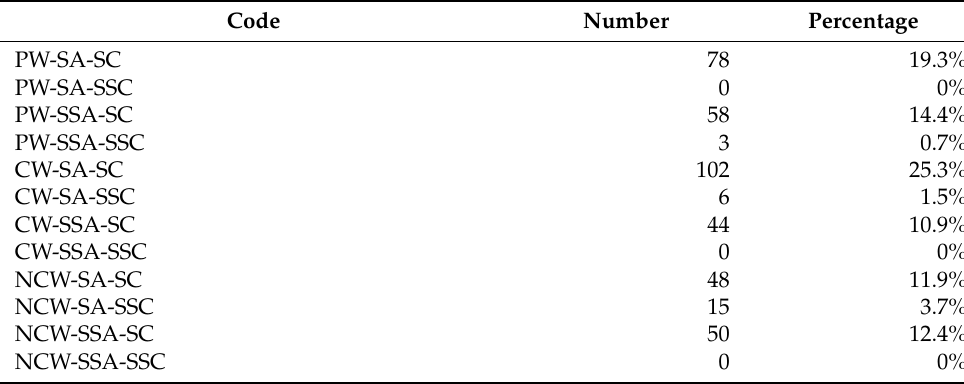
Table 6. Application of new classification and video snapshots.